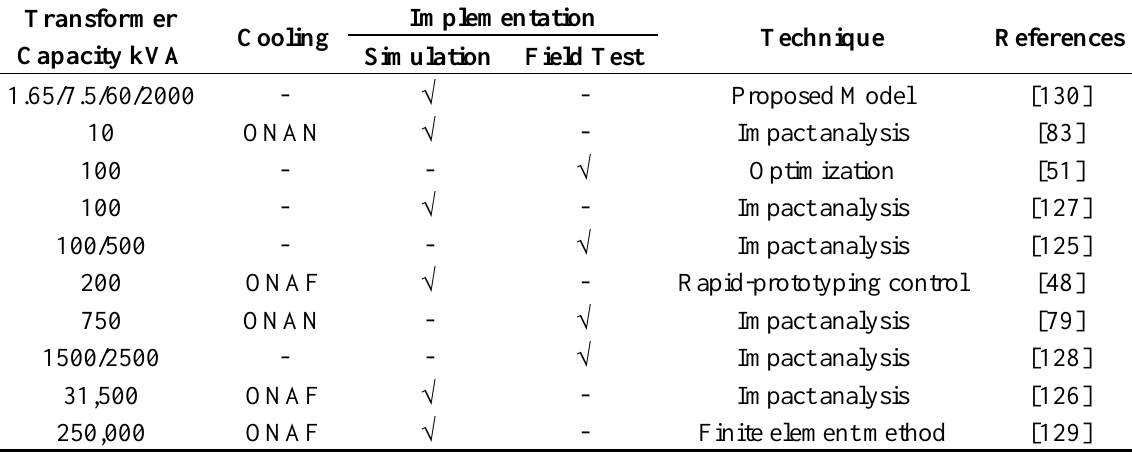
Table 3. Transformers on which the ageing is influenced by